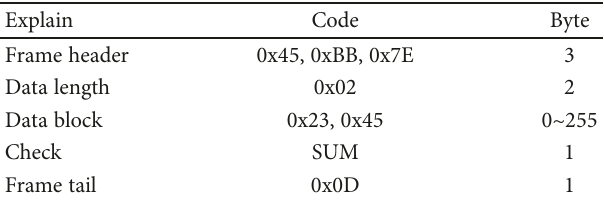
Figure 16: Host computer software. Table 1: Format